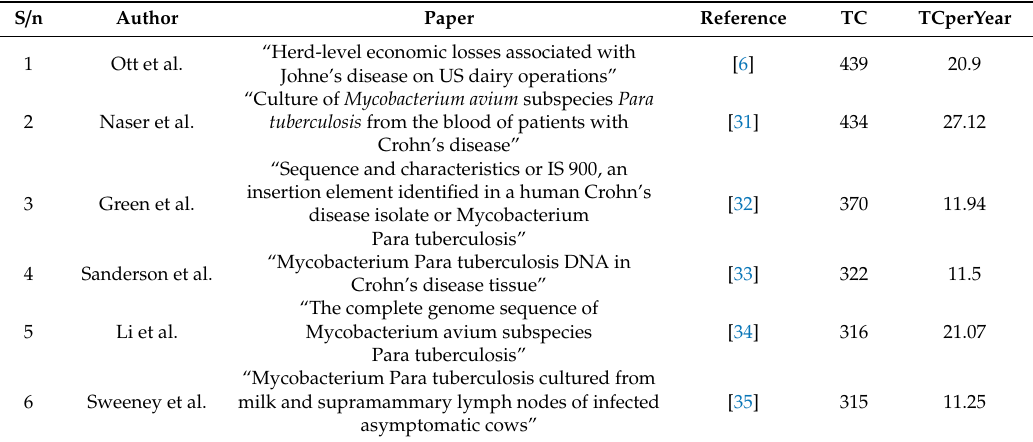
Table 3. The top cited titles in MAP research from 1911 to